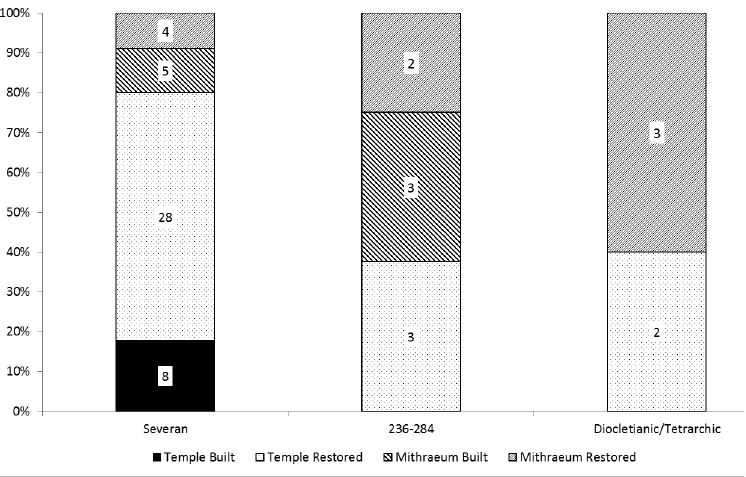
Figure 2: Construction and restoration of general temples vs. Mithraea in Noricum and Pannonia (Walsh,